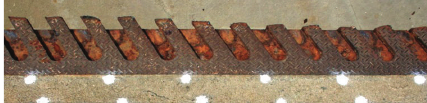
of failure in the anchorage systems of these joints, especially those that were skewed. It was recommended that future joint anchorages should be cast integrally with the surrounding concrete and tied to the reinforcing steel